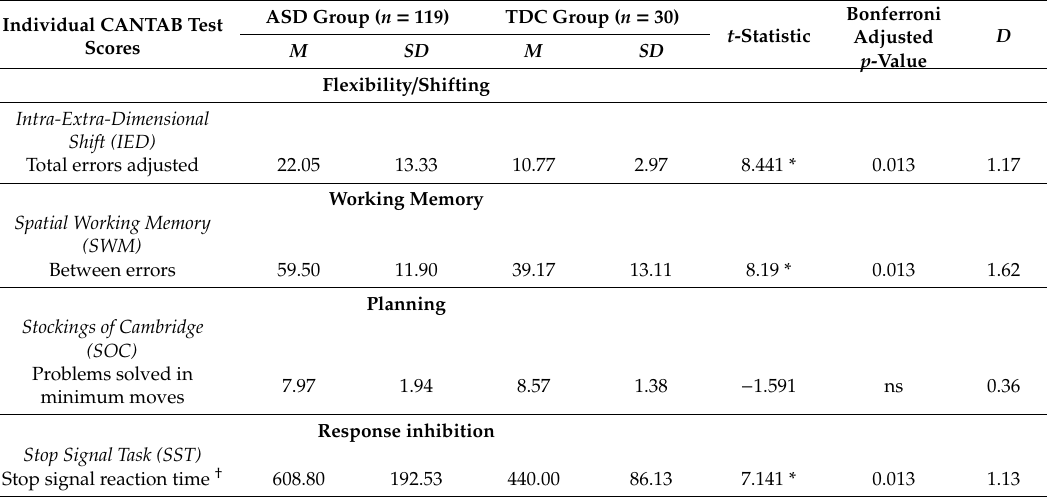
Table 6. Comparing the ASD and control groups based on the CANTAB test